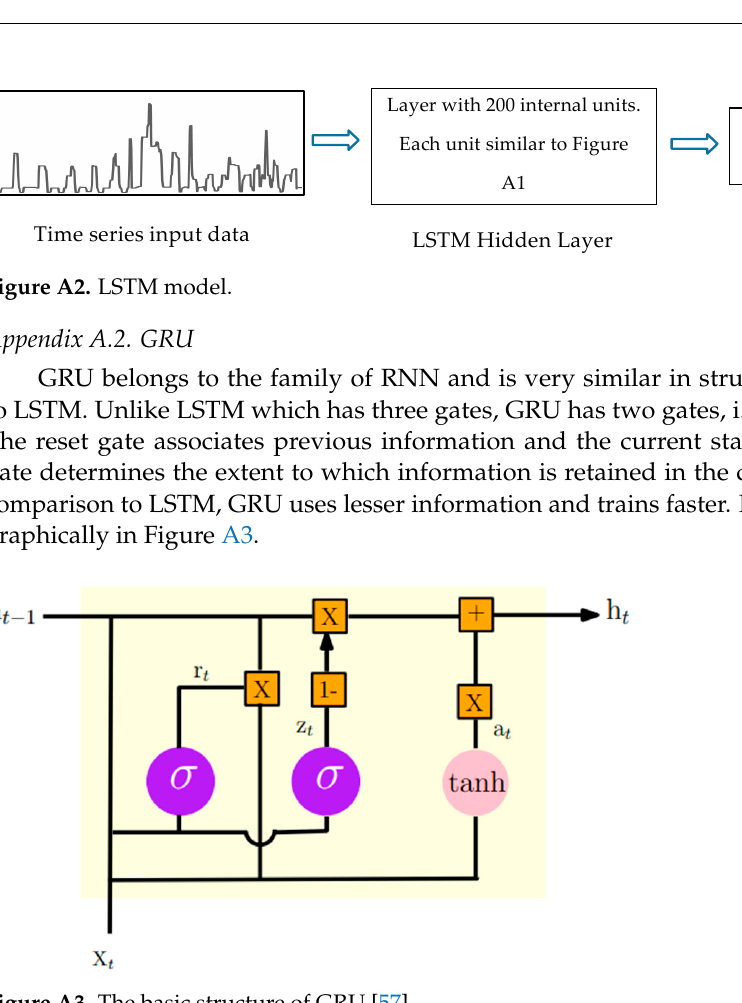
Figure A3. The basic structure of GRU [57].